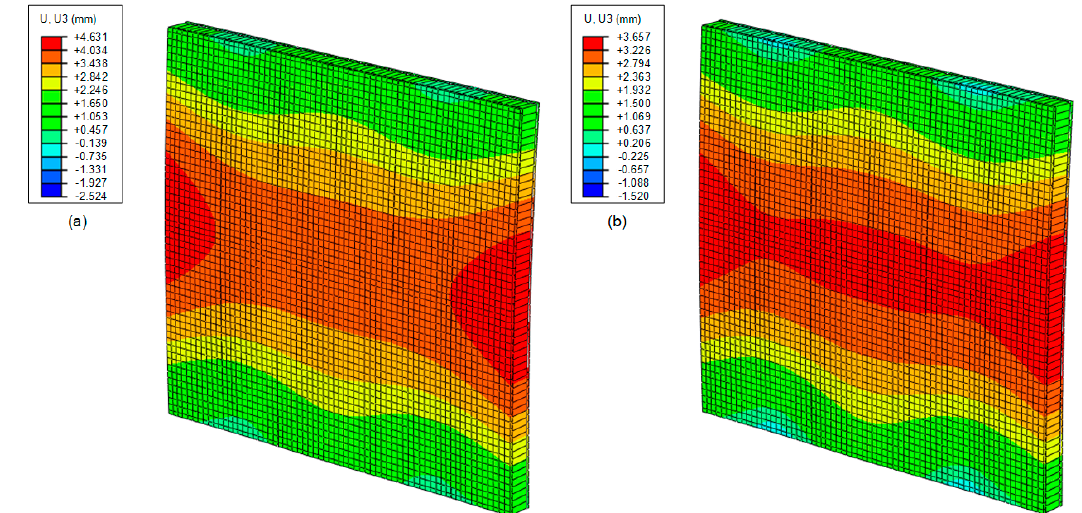
Figure 14. Contour plot of the out-of-plane displacement at a wind pressure of 2.0 kPa for element with single (S) connectors ( a ) and element with double (D) connectors ( b ).